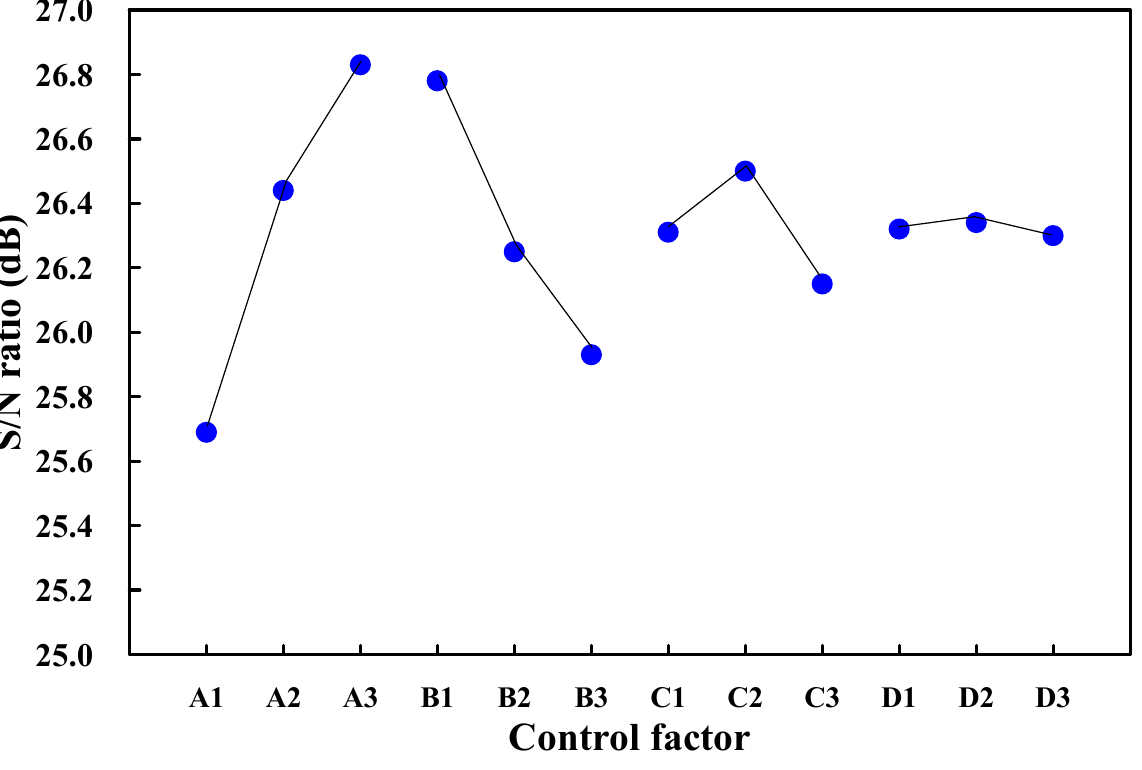
Figure 11. S/N ratio effects of each process control factor.